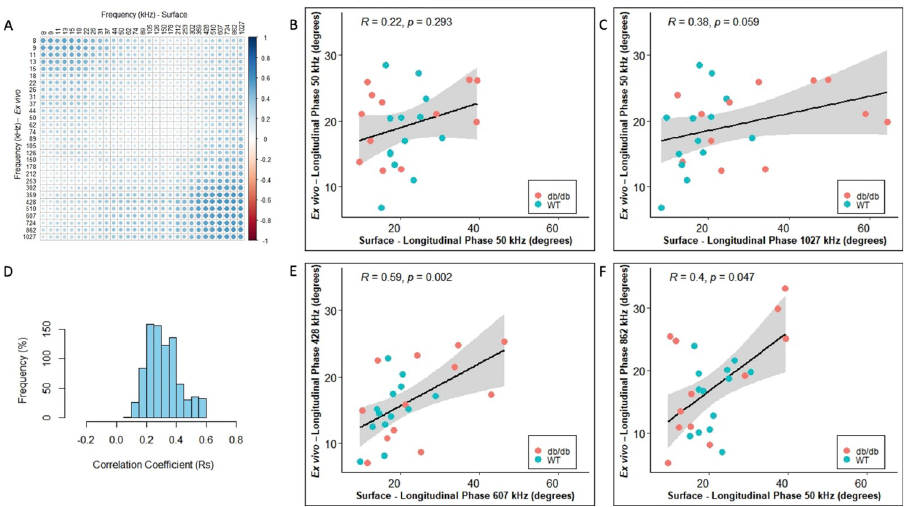
Fig 3. db/db with Wild Type (WT) mice data (left GA muscles) for longitudinal phase orientation (N = 25, 12 db/ db and 13 WT = C57Bl/6). A. Heat-map with correlation coefficient related to individual frequency spectrum on Ex vivo and Surface impedance (phase) measurements, B. Linear correlation plot for 50 kHz Ex vivo and 50 kHz Surface impedance (phase) measurements, C. Linear correlation plot of surface vs ex vivo phase values at frequencies corresponding to the maximum correlation coefficient given Ex vivo impedance (phase) frequency is at 50 kHz, D . Histogram indicating the frequency of all possible correlation coefficients (Rs), E. Linear correlation plot of surface vs ex vivo phase values at frequencies corresponding to the maximum correlation coefficient within the spectrum and F. Linear correlation plot of surface vs ex vivo phase values at frequencies corresponding to the maximum correlation coefficient given Surface impedance (phase) frequency is at 50 kHz.